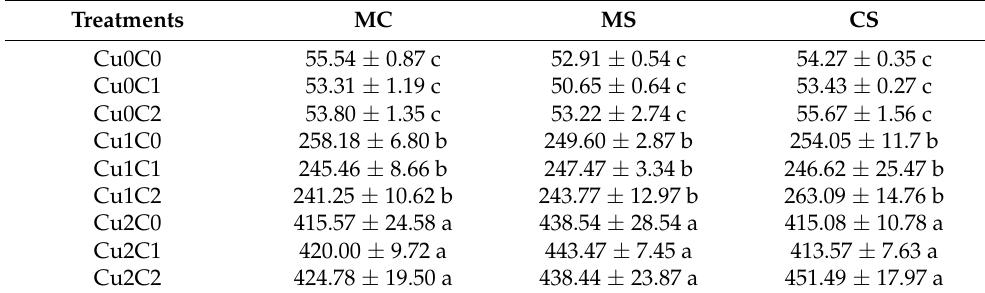
Table 3. Soil Cu concentration (mg · kg − 1 ). Treatments